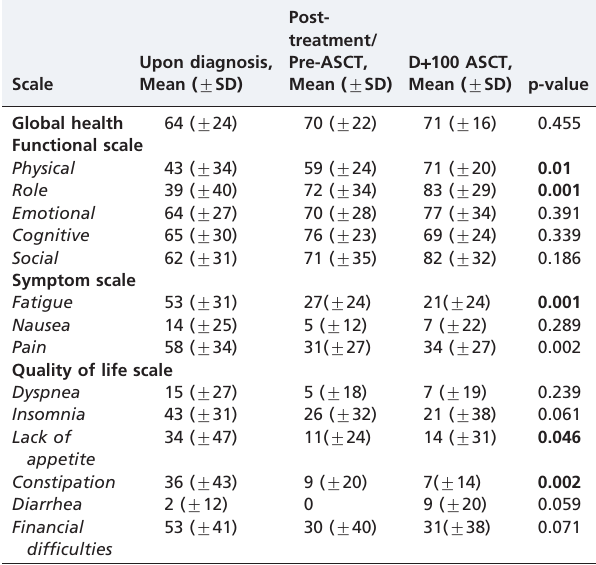
Table 3 - Analysis of variance (ANOVA) comparing the three groups according to the QLQ-C30